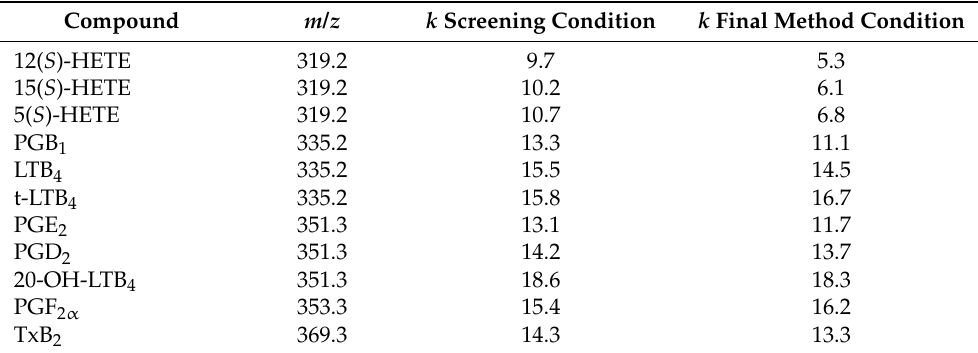
Table 1. Capacity factors of eicosanoids included in the method and their corresponding m/z values for detection by mass spectrometry.